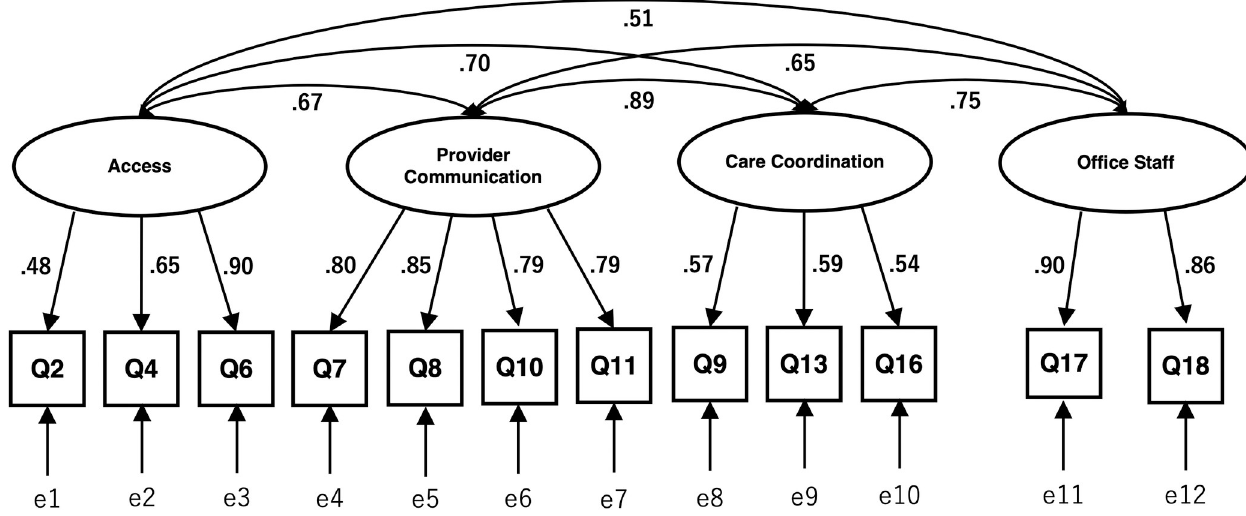
Fig 1. Factor structure of Japanese CG-CAHPS (confirmatory factor analysis). Squares are observed variables (items); ellipses are latent variables (factors), values on the single-headed arrows are standardized factor loadings, values on the double-headed arrows are correlation coefficients. CG-CAHPS = Consumer Assessment of Healthcare Providers and Systems Clinician & Group Survey.